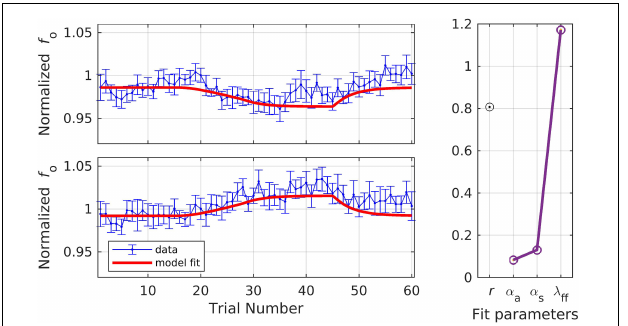
FIGURE 9 | Simulation 7: model fits of a dataset with perturbations applied to fundamental frequency in both shift-up and down directions [normalized by an unshifted control condition; data from Heller Murray (2019)]. Shift-up and down data are fit simultaneously. Measurement of fundamental frequency was taken early in the trial (20–120 ms after voicing onset). (Left) Mean and standard error of experimental data in blue; model fit in red. (Right) Fit quality and optimized parameter values ( r = correlation coefficient; α A = auditory feedback control gain, α s = somatosensory feedback control gain, and λ FF = learning